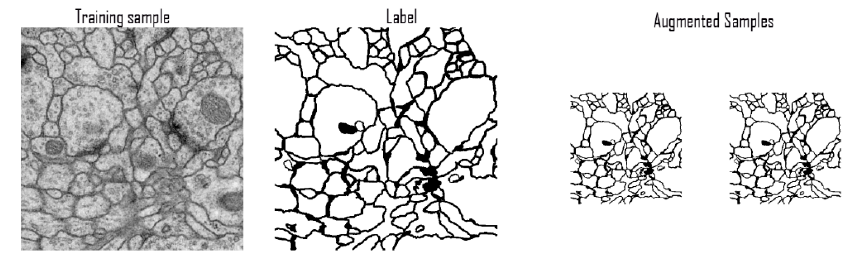
Figure 7. Samples of ISBI training data.